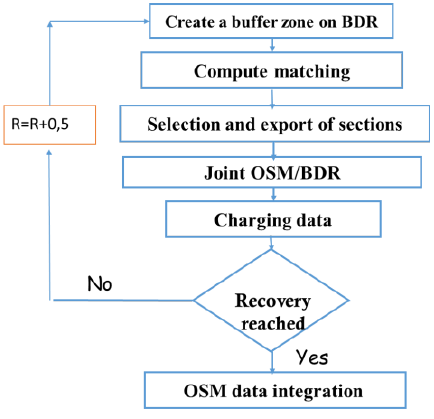
Figure 3. Organigram - calculating matching features